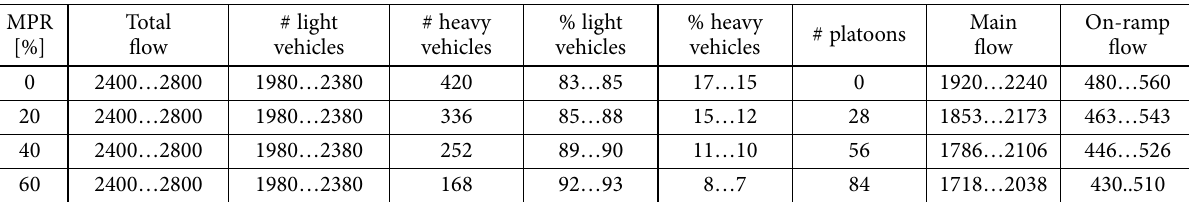
Table 2. Model input for different MPR